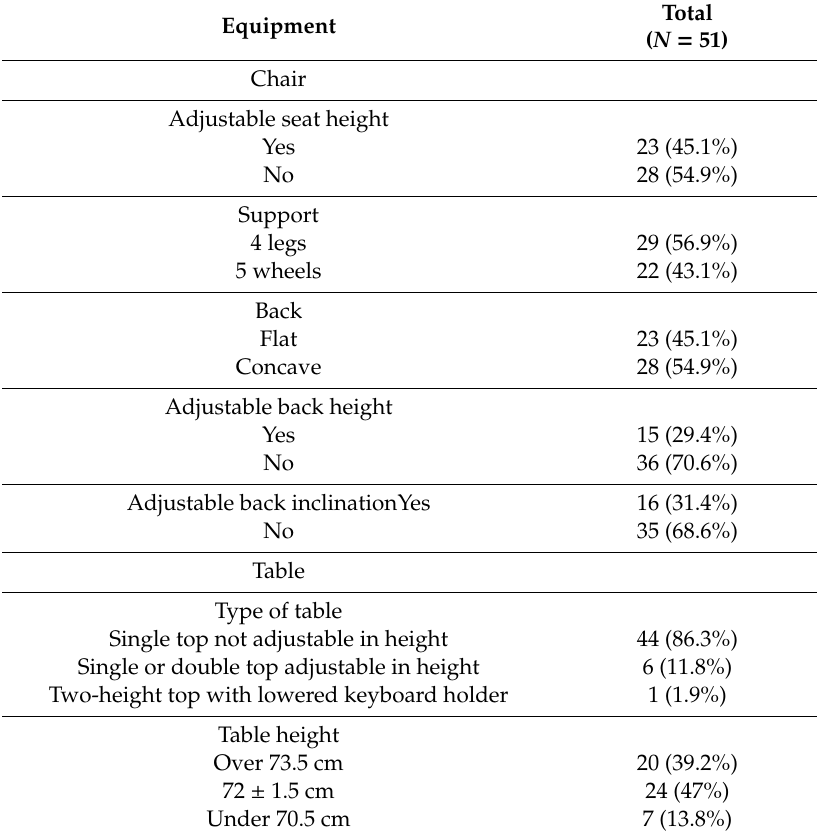
Table 8. Home working equipment characteristics: work chair and